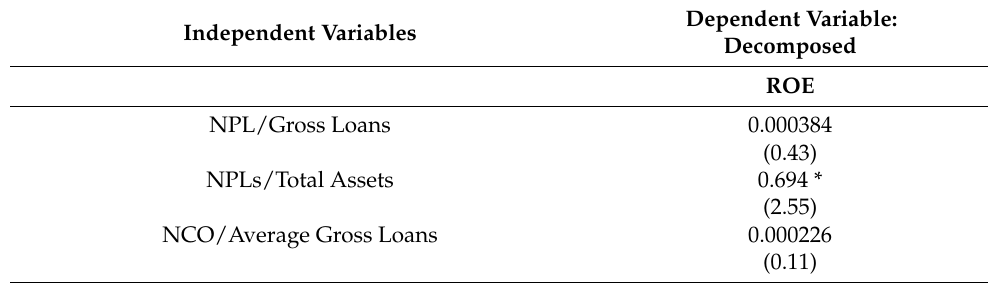
Table A12. Panel regression (with fixed effects for banks and time and robust standard errors) with decomposed ROE (measured as addressed by ECB (2010)) as the dependent variable and ratios describing the major characteristics of the banks as independent variables (directly extracted from ORBIS). The complete sample is made up of 142 Italian banks and the timespan is from 2011 to